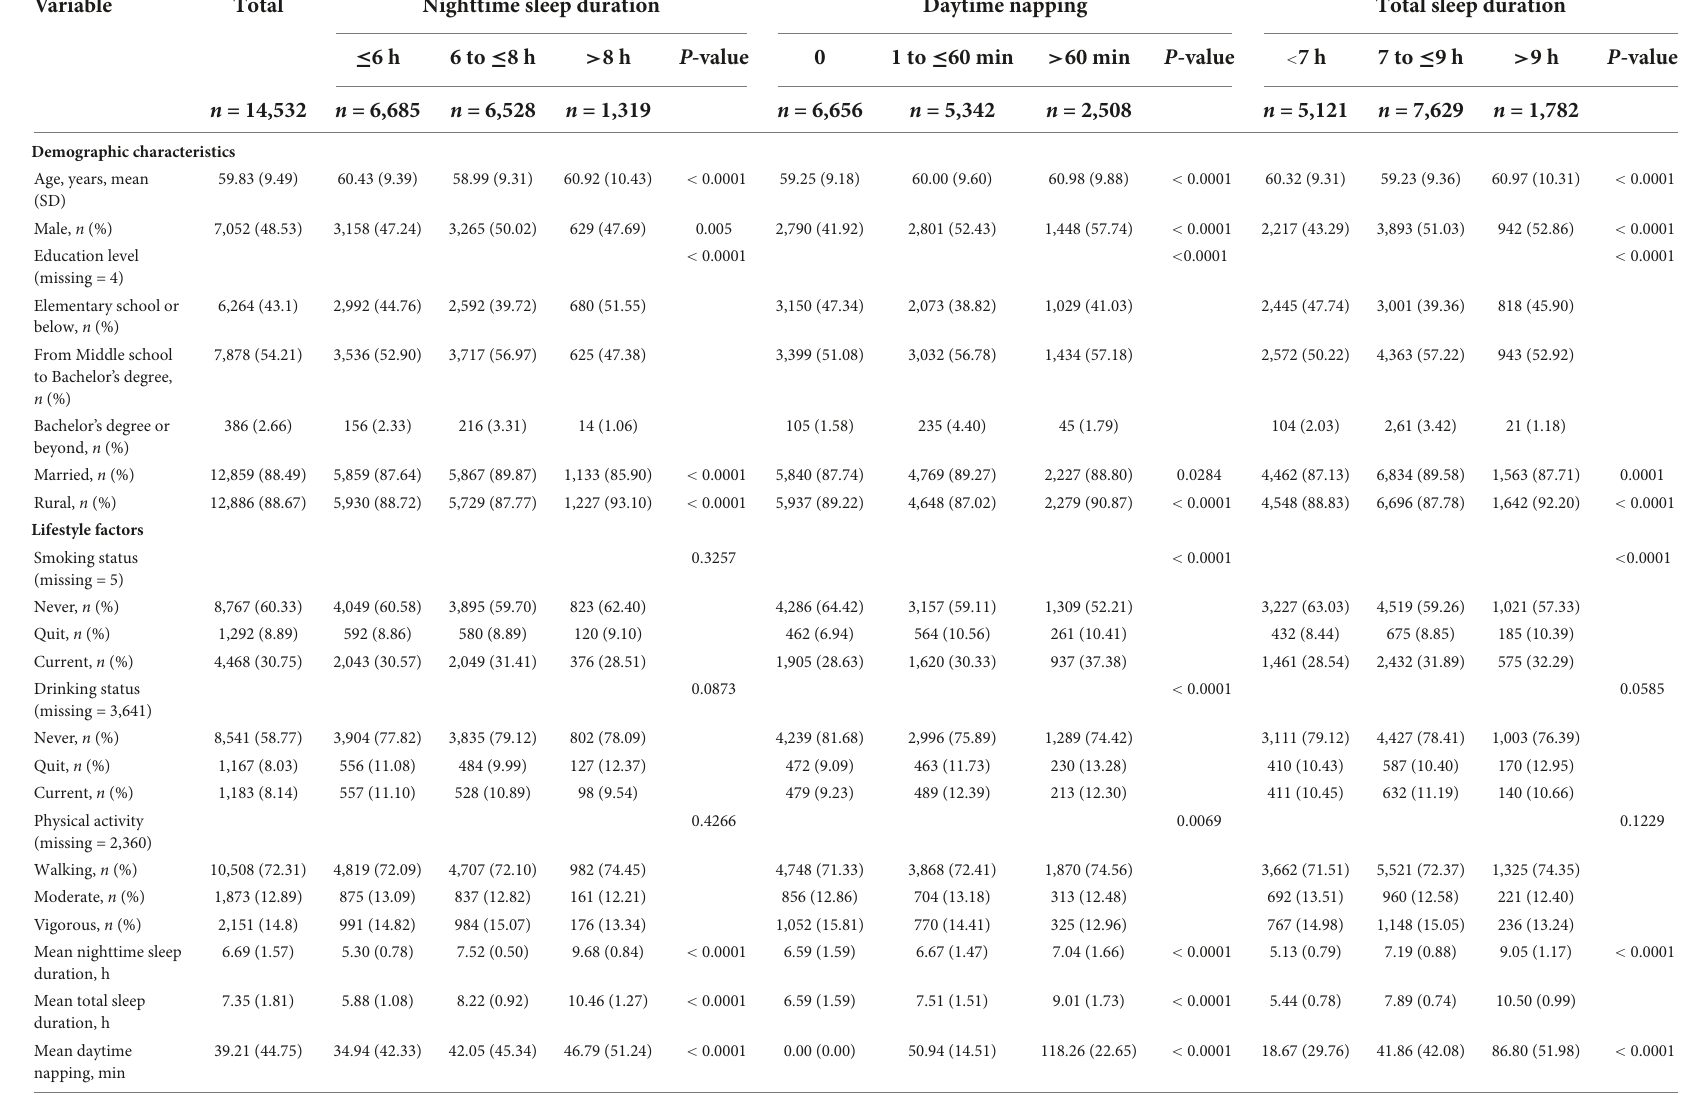
TABLE 1 Baseline sample characteristics according to sleep